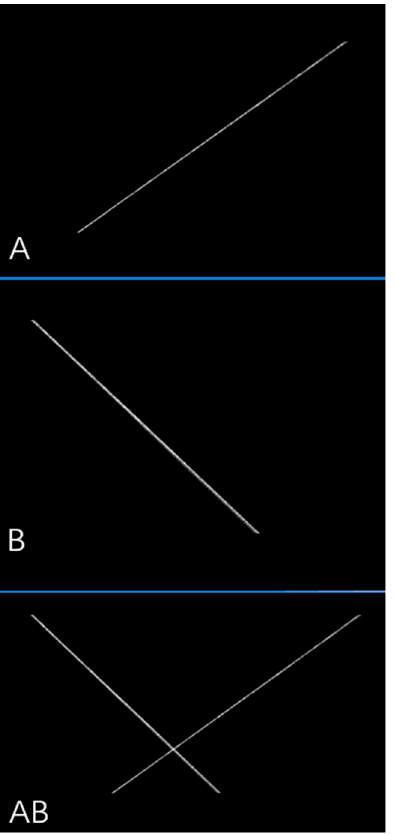
Figure 4. Laser A opened ( top ), laser B opened ( middle ), and laser AB opened ( bottom ).